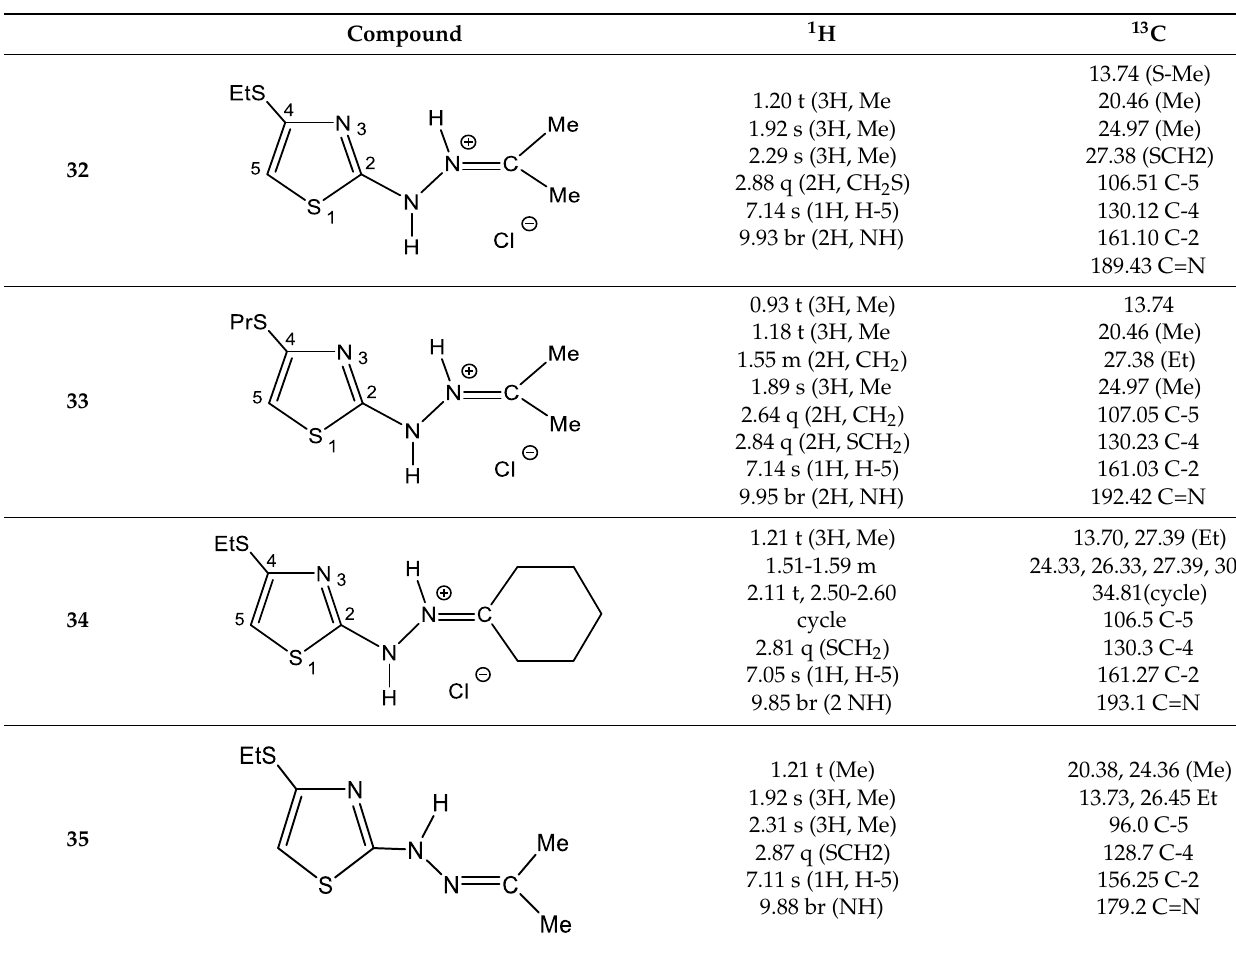
Table 7. 1 H and 13 C NMR chemical shifts of 2-alkanone- N -[4-(organylthio)-1,3-thiazol-2-yl] hydrazones ( 32 - 35 ) (DMSO- d 6 ).